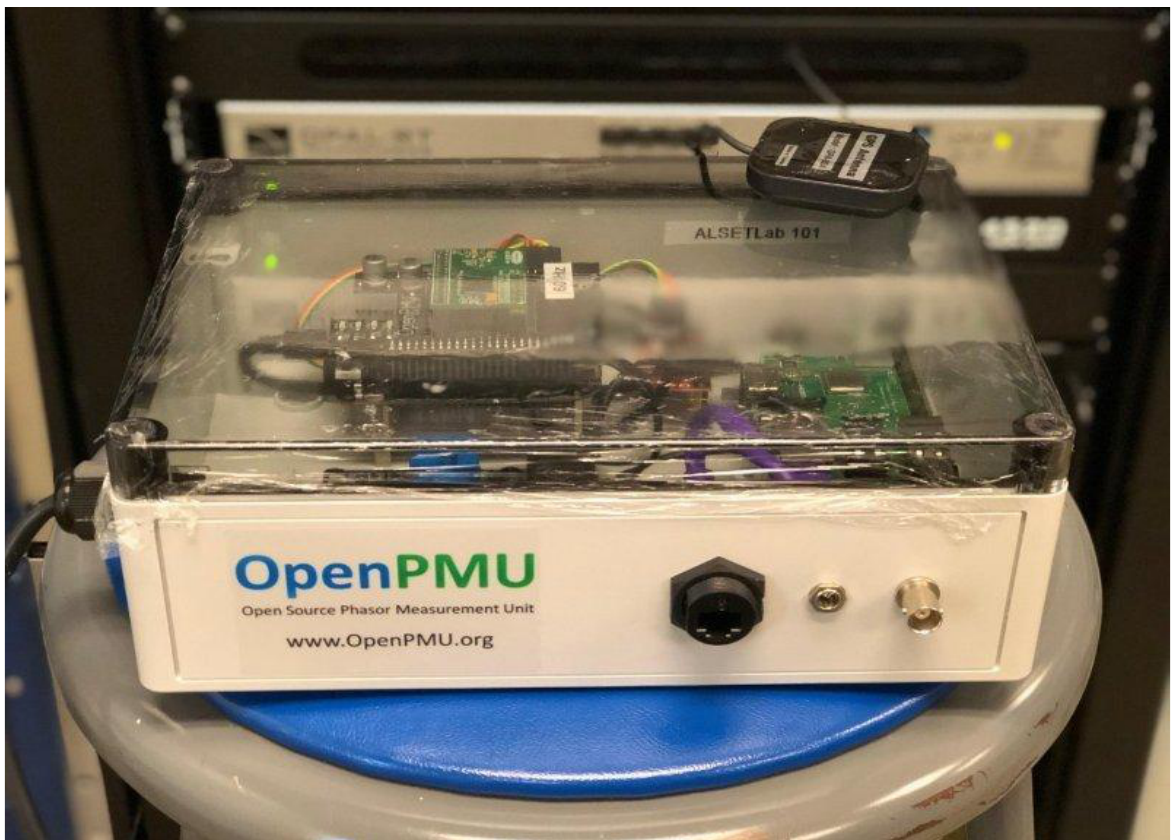
Figure 3. OpenPMU V2. Photo: Credits to Dr Luigi Vanfretti [23]. Table 1. Comparative results among low-cost PMUs.